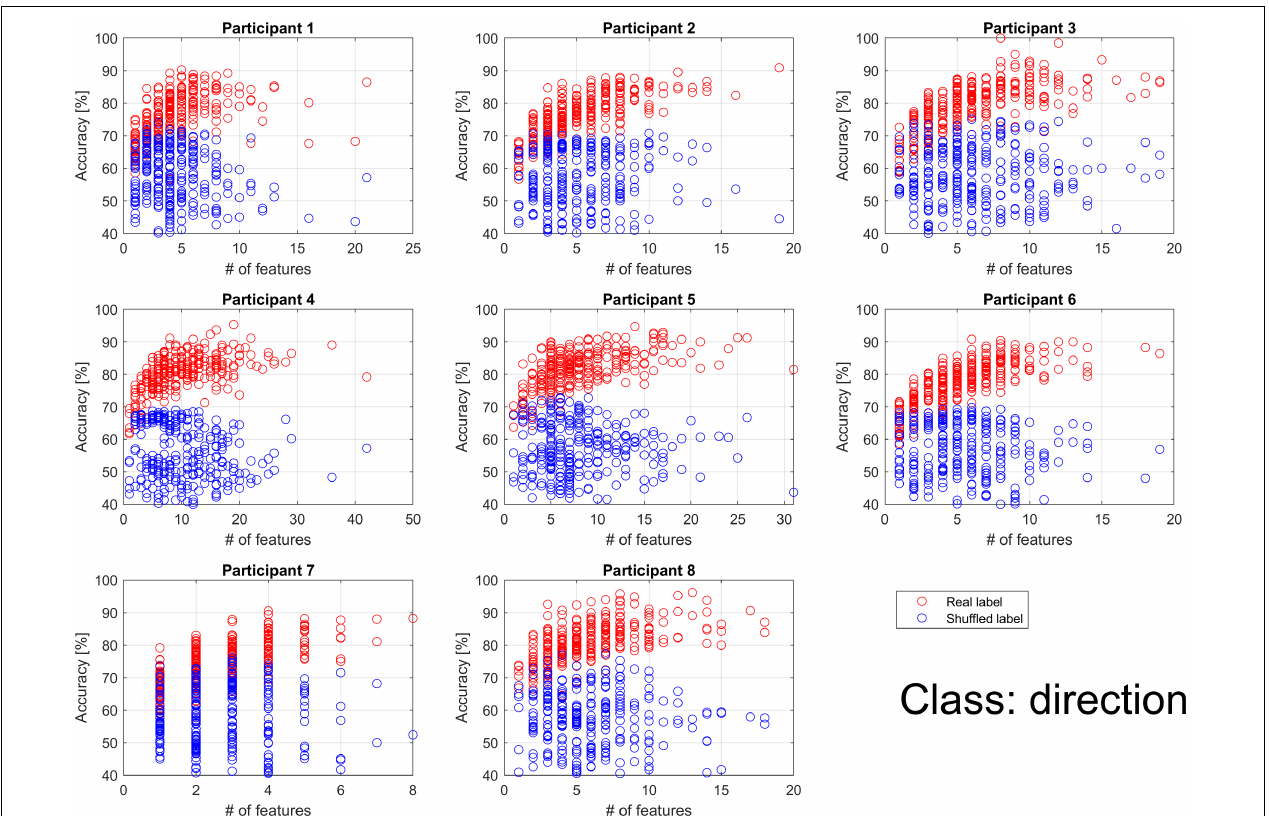
FIGURE 5 | Individual classification accuracy for direction according to the number of features. Each dot represents the accuracy for each binary classification. The binary classifications were performed 276 times (24 choose 2) per participant when the feature for all classifications had at least 1. Blue circles represent the result when shuffled labels were used. Red circles represent the result when real labels were used. Performance for the real label increased in proportion to the number of features, while performance for the shuffled label did not depend on the number of features. However, performance for the real label was saturated for all participants.